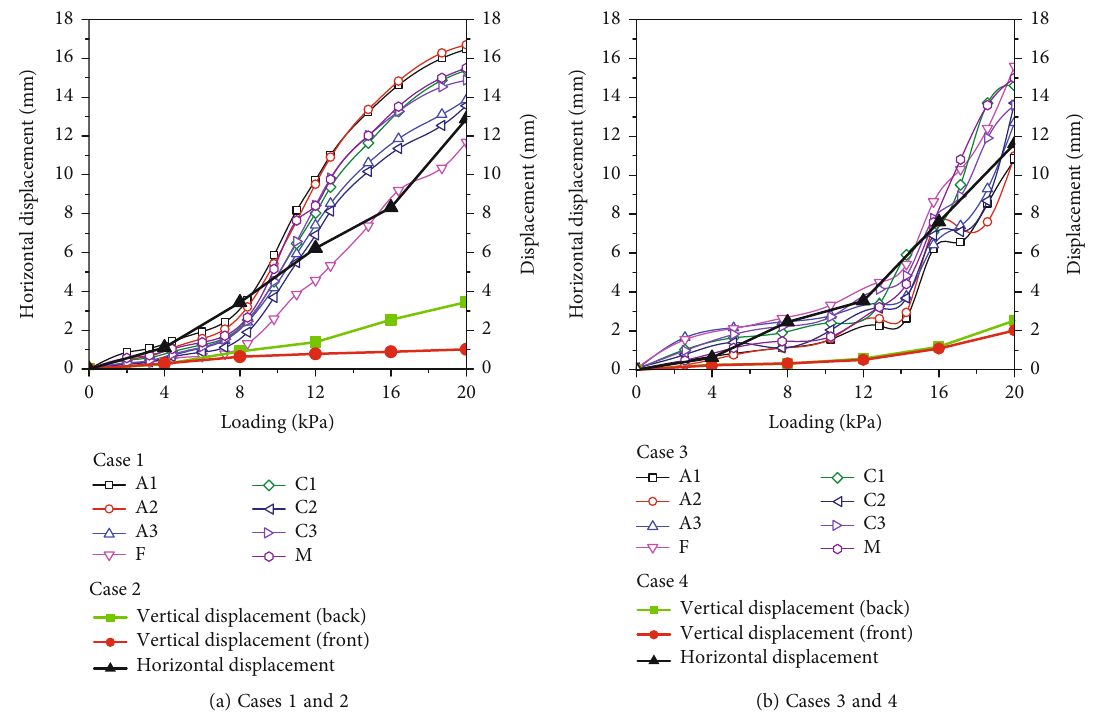
Figure 9: Displacement of pile top under di ff erent